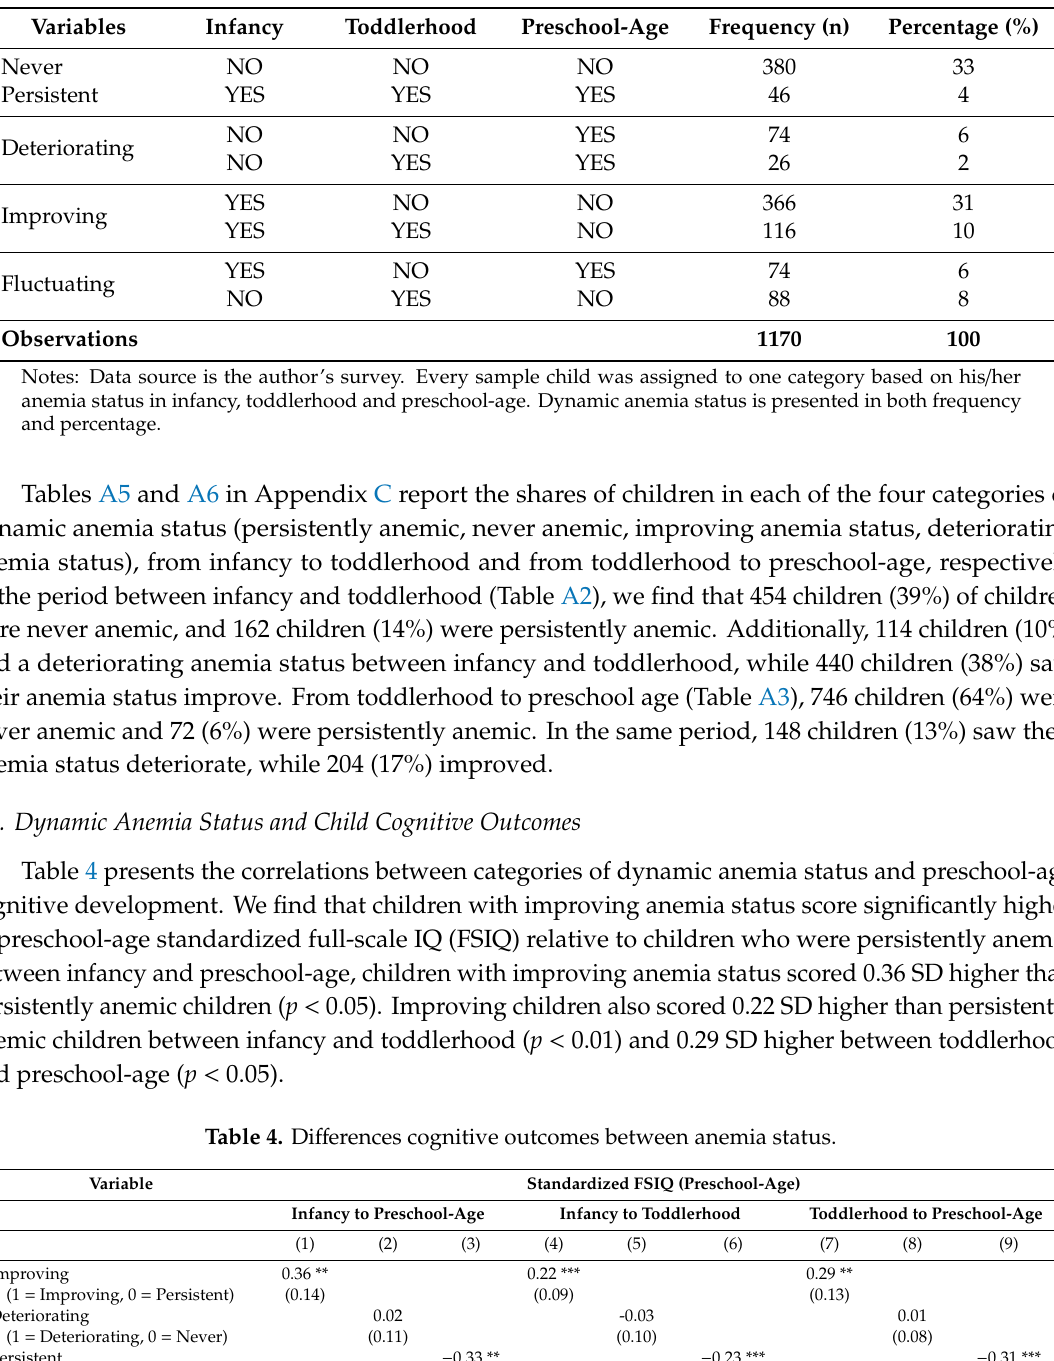
Table 3. Dynamic anemia status from infancy to preschool-age.